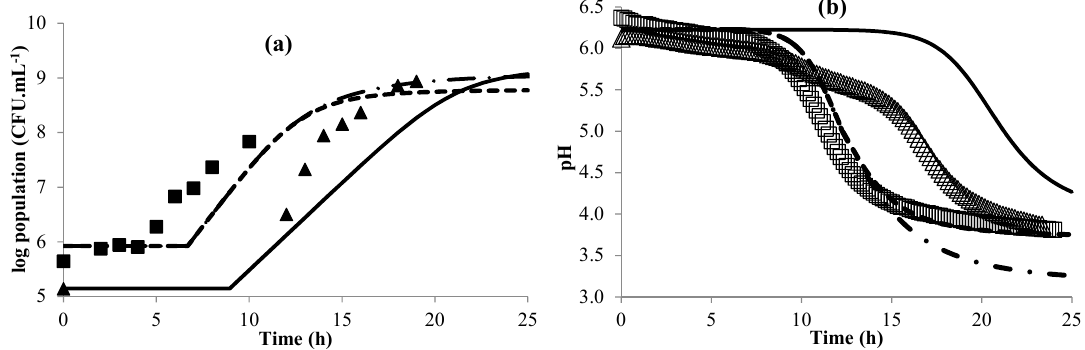
Figure 8 . Changes in the log population ( a ) and in pH ( b ) for the validation tests. Experimental data for L. plantarum ( (cid:4) , (cid:3) ) and L. brevis ( (cid:78) , (cid:52) ). Modeled curves for L. plantarum (complete model, —; model without dissociated lactic acid gamma parameter -·-) and L. brevis (complete model, - - -; model without dissociated lactic acid gamma parameter, -).